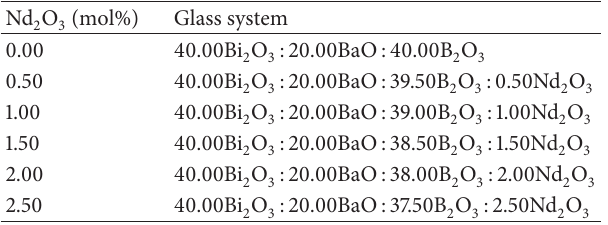
Table1:Chemicalcompositionsoftheglasssystemspreparedinthis